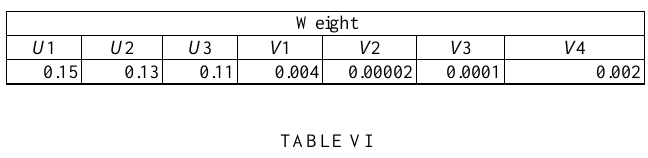
G ENERALIZED C RITERIA OF M ODELS S UITABILITY OF E ACH M ATHEMATICAL M ODEL C ALCULATED BY DEA Multivariable nonlinear Model Multivariable regression GRNN f Р = f ( Q 5 ) + f ( Q 8 ) linear n + f ( Q 11 ) regression Polynomial